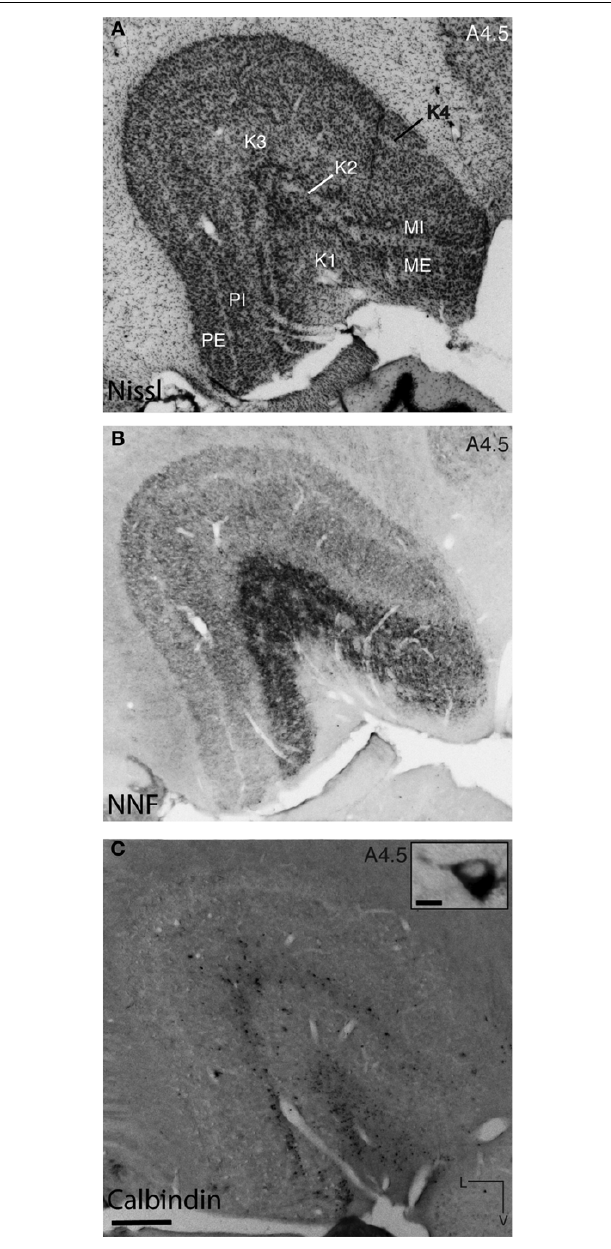
FIGURE 2 | Photomicrographs of adjacent coronal sections of the marmoset LGN processed with different histological and immunohistochemical stains enable demarcation of the magnocellular, parvocellular and koniocellular layers. (A) Section stained with cresyl violet (Nissl bodies) revealing the large cells of the magnocellular layers (MI and ME) and the smaller cells in the two parvocellular layers (PI and PE). (B) Immunostaining for NNF shows an increase in reactivity in both cells and neuropil in the magnocellular layers compared with the parvocellular layers, making them clearly discernible. In both the Nissl substance and NNF stains, it is diffi cult to discern the discrete koniocellular (K1-4) layers, but staining with an antibody for calbindin-D28k (C) reveals these layers. Inset: Calbindin-D28k- immunoreactive cell in layer K3 of the LGN. All three protocols were used to demarcate the laminar borders in the LGN for the purposes of digitizing and the overlay of retinal afferents and area MT relay cells. L, lateral; V, ventral; scale bar = 500 µm, inset scale bar = 10